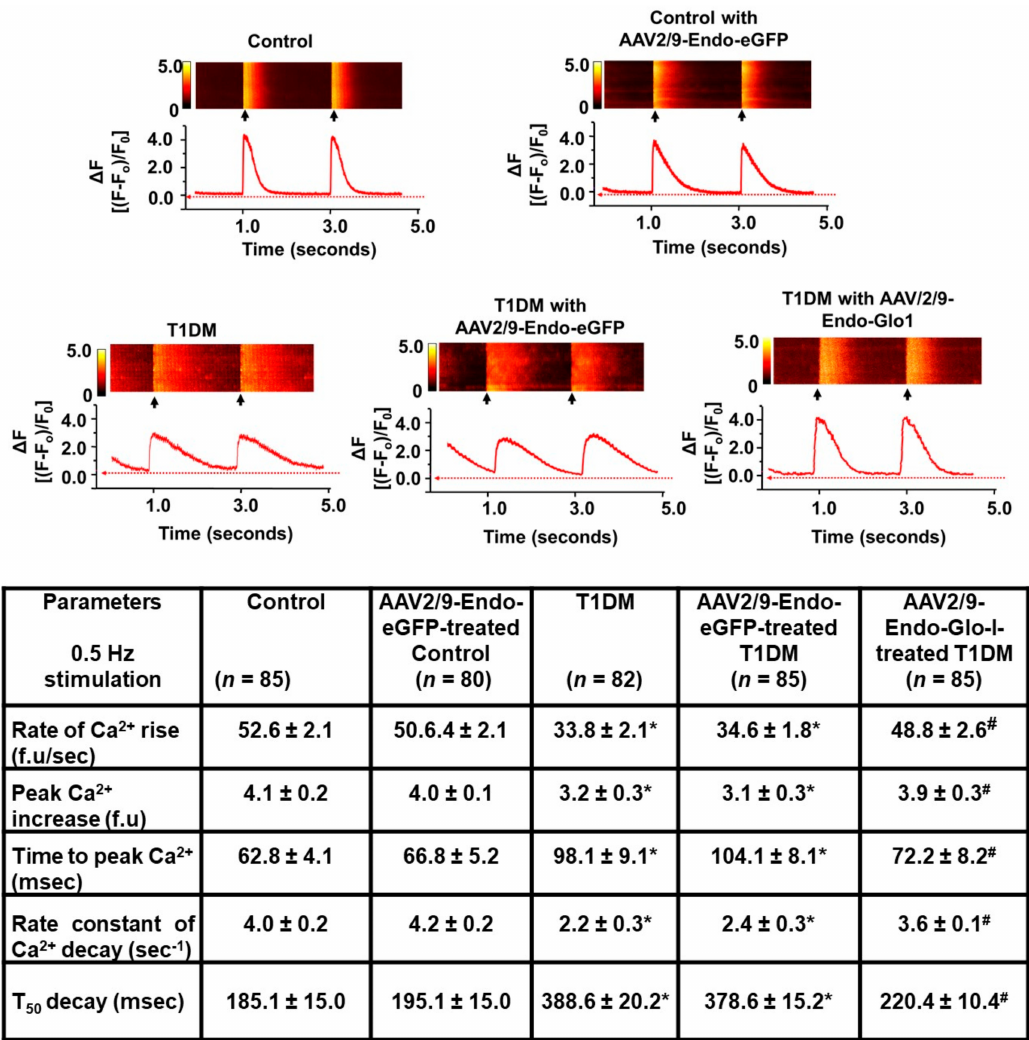
Figure 4. Original traces showing evoked Ca 2 + transients in left ventricular myocytes isolated from the control, T1DM, and T1DM-treated hearts. Images above are representative line Ca 2 + transients from ventricular myocytes isolated from the control, AAV2 / 9-Endo-eGFP-treated Con, T1DM, AAV2 / 9-Endo-eGFP-treated T1DM, and AAV2 / 9-Endo-Glo1-treated T1DM rats preloaded with the Ca2 + fluorophore dye Fluo-3 and field stimulated at 0.5 Hz. Data shown in Table below are mean ± S.E.M for n > 80 cells from n = 5 animals are listed in the table below. * denote significantly di ff erent from the control ( p < 0.05), # denote significantly di ff erent from T1DM ( p <